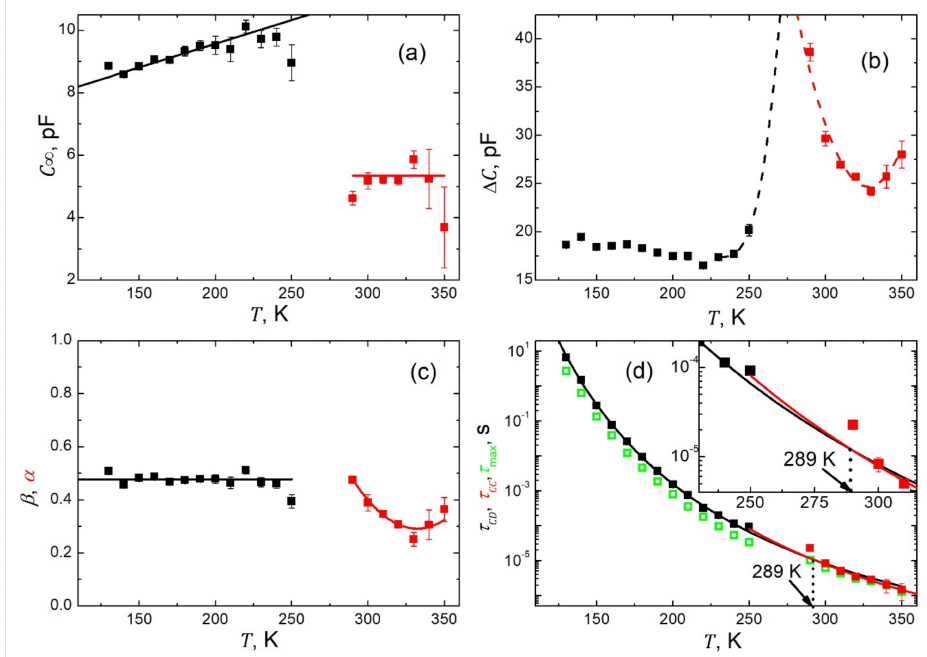
Figure 8. Temperature dependences of the fitting parameters from the best fits of the C (cid:48)(cid:48) vs. C (cid:48) data to Equations (5) and (6), respectively. ( a ) High frequency limit of the capacitance C ∞ = lim The solid lines are to guide the eyes. ( b ) Relaxation strength ∆ C = C S − C ∞ . The dashed lines anticipate possible dependences around the phase transition point. ( c ) Shape parameters β (black squares) and α (red squares). The solid lines are to guide the eyes. ( d ) Cole–Davidson τ CD and Cole–Cole τ CC relaxation times (black and red squares respectively). The solid lines represent the best fit to Arrhenius law τ = τ 0 exp ( E a / k B T ) with τ 0 = 2.31 ( 28 ) · 10 − 10 s and E a = 0.2708 ( 18 ) eV for the black curve, and τ 0 = 0.30 ( 13 ) · 10 − 10 s and E a = 0.322 ( 12 ) eV for the red one. For comparison, the relaxation time τ max , determined from the maximum of the imaginary part of the capacitance (green open squares), is